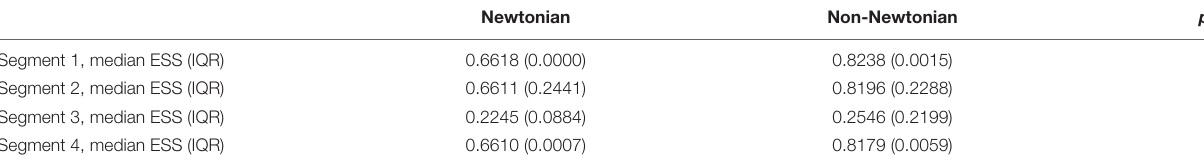
TABLE 3 | ESS distribution between rheology models in an idealized artery (as depicted in Figure 1 ). Newtonian Non-Newtonian